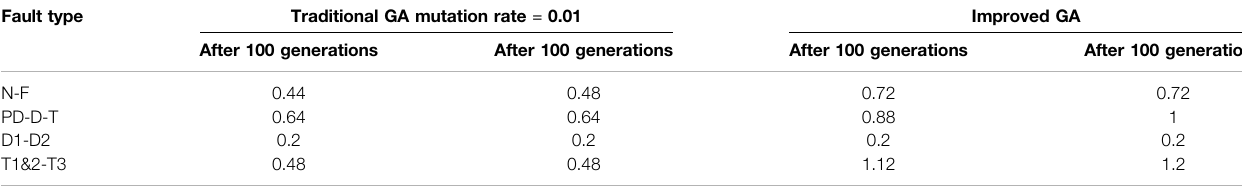
TABLE 4 | Likelihood of evolution leap Lel(k).